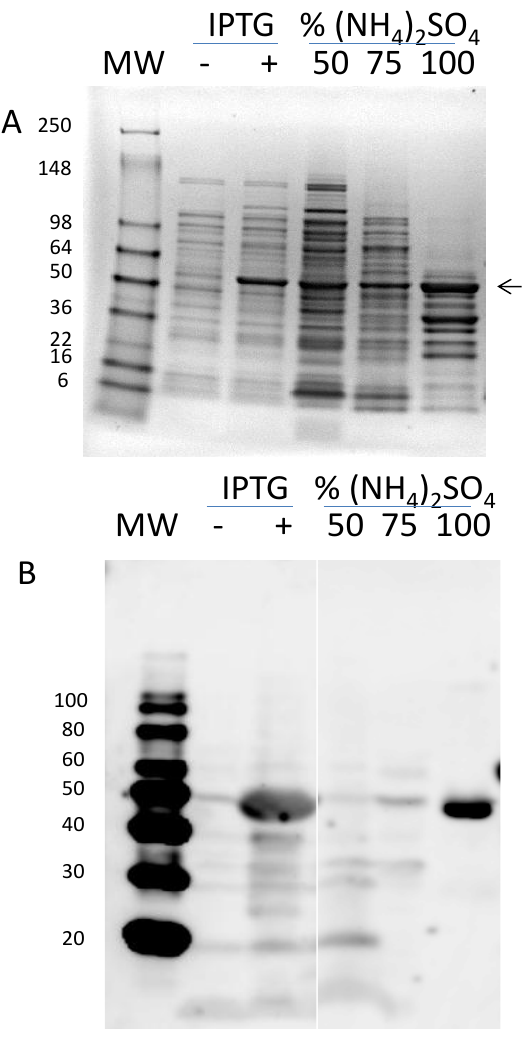
Figure 4. ( A ) SDS-PAGE of induced (+) and uninduced (−) cells and ammonium sulfate precipitations tests. ( B ) Western blot analysis of the same samples shown in